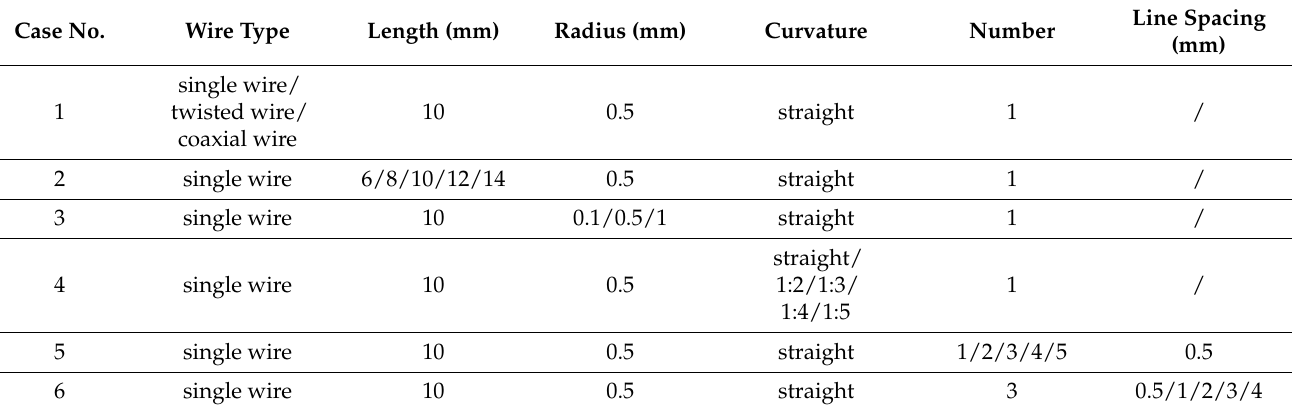
Table 3. Settings for the simulation cases.